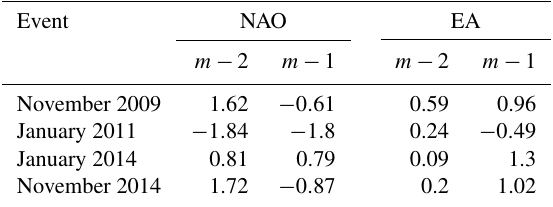
Table 2. NAO and EA indexes in the previous 2 months of the events. m − 2 means 2 months before the event whereas m − 1 means 1 month